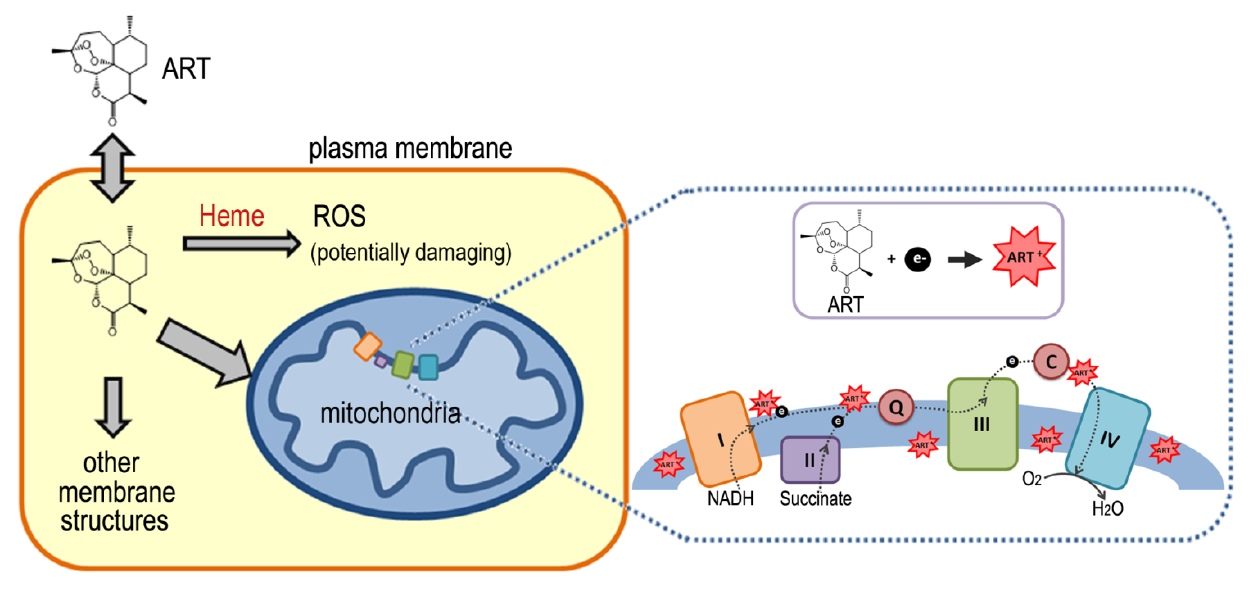
FIGURE 3: What happens to ART when it gets into cells? A schematic showing how ART behaves in the context of a cell. ART is permeable to the cell membrane. Inside the cells, it is preferentially distributed to all membranes due to its poor solubility in aqueous solution. ART reacts with accessible heme and as a result, generate ROS, which is a potentially damaging agent. When this ROS level is high, relatively non-specific damages could be inflicted to the cell. This action is heme-dependent and could explain ARTs’ action against cancer cells and yeast on fermentable media. A portion of ART gets into mitochondria, where a potent and specific action might occur, depending on the species. In malaria parasites and Baker’s yeast, the mitochondria and ART interact with each other and generate mitochondrial dysfunctions, whereas in mammalian cells little mitochondrial actions was observed. The nature of how ART is activated in mitochondria is not